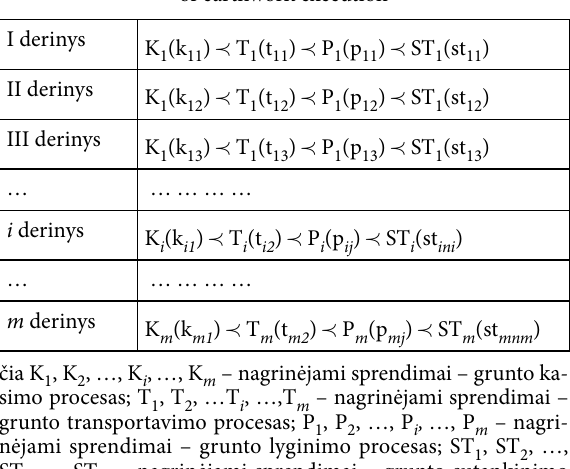
Table 2. Options on the partial processes of earthwork